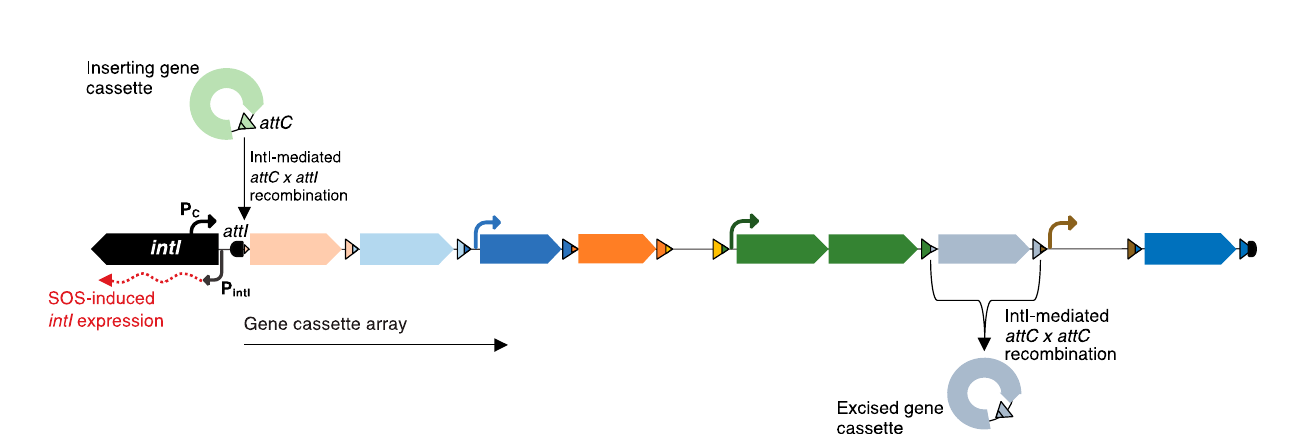
Figure 1. Structure and function of integrons. The typical structure of a chromosomal integron includes an integron integrase gene ( intI ), which encodes a tyrosine recombinase (IntI); an integron recombination site ( attI ); and a cassette array made up of 1–200+ sequential gene cassettes. All gene cassettes carry a cassette recombination site ( attC ) and generally consist of a single open reading frame (ORF), though cassettes that have two ORFs or no ORFs have also been observed. Some gene cassettes with two ORFs encode toxin–antitoxin systems. Cassettes closest to attI are strongly expressed from the cassette promoter (P c ); however, some cassettes have their own promoters (bent arrows). Expression of intI (red, dotted arrow) is driven from the promoter (P intI ) and is induced by the bacterial SOS response. IntI catalyses the insertion and excision of gene cassettes by mediating attC x attI and attC x attC recombination, respectively.